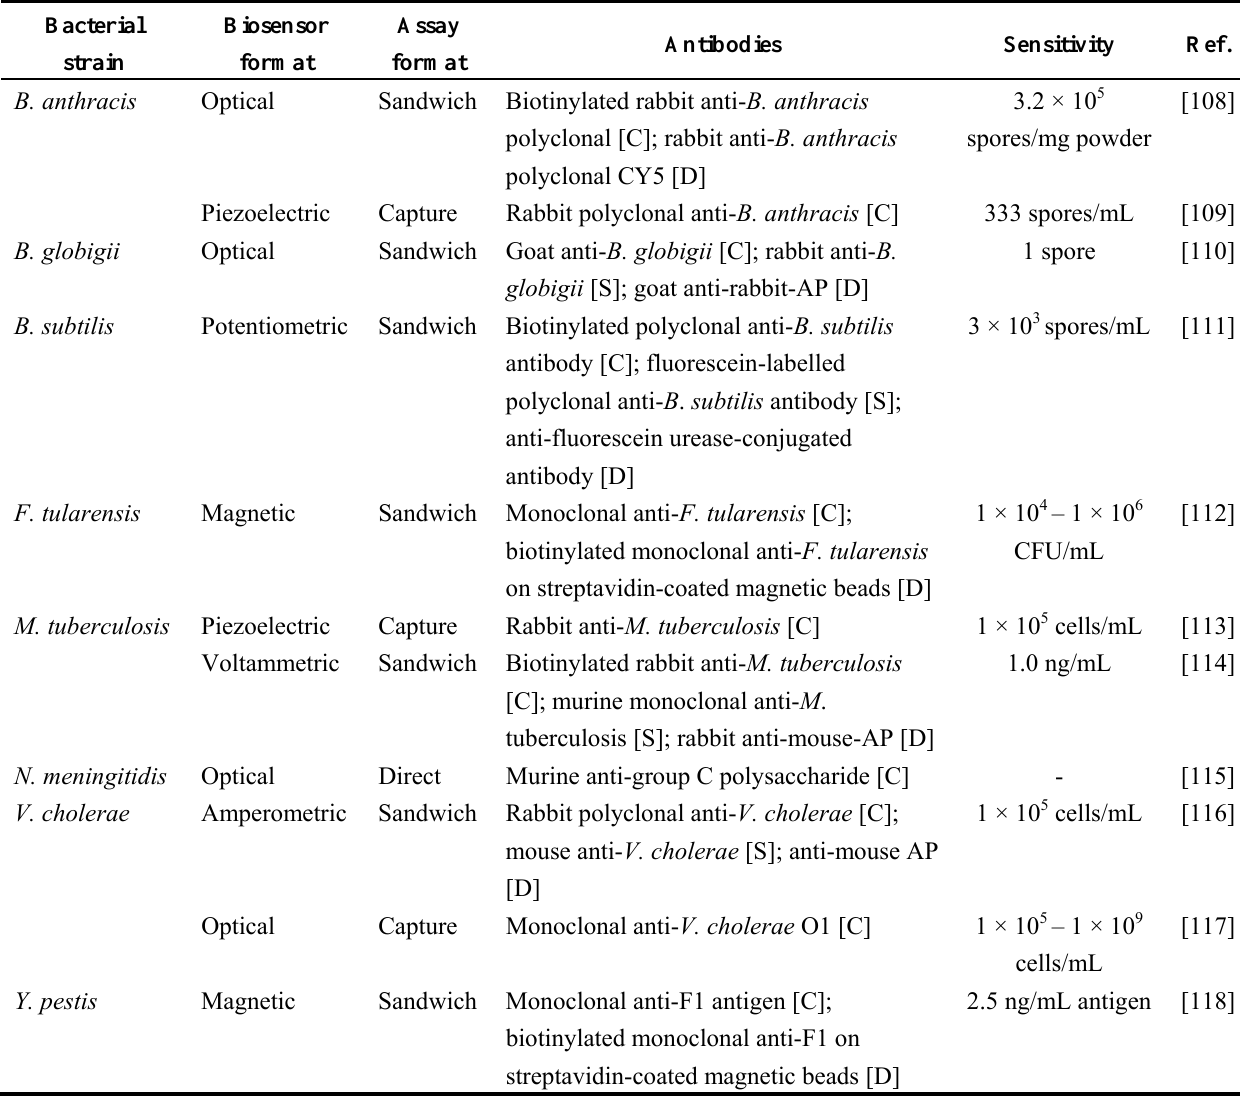
Table 4. Immunosensor-based detection of selected bacterial pathogens. Key: [C] - capture antibody; [S] - secondary antibody; [D] - detection